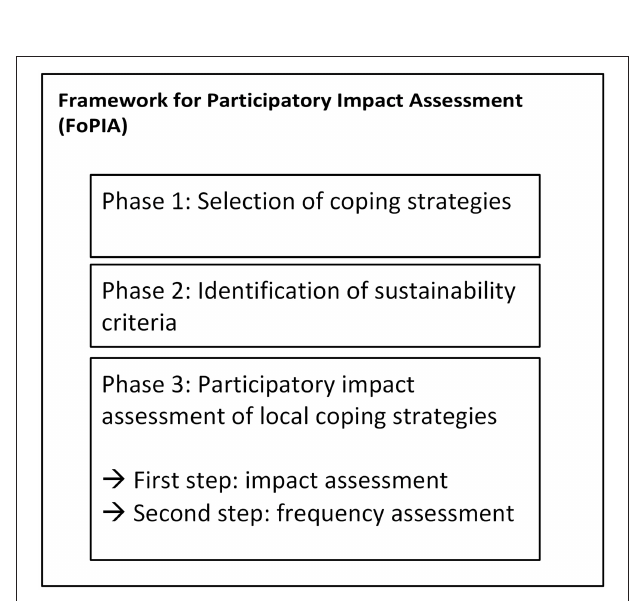
FIGURE 2 | Process of the applied methodological